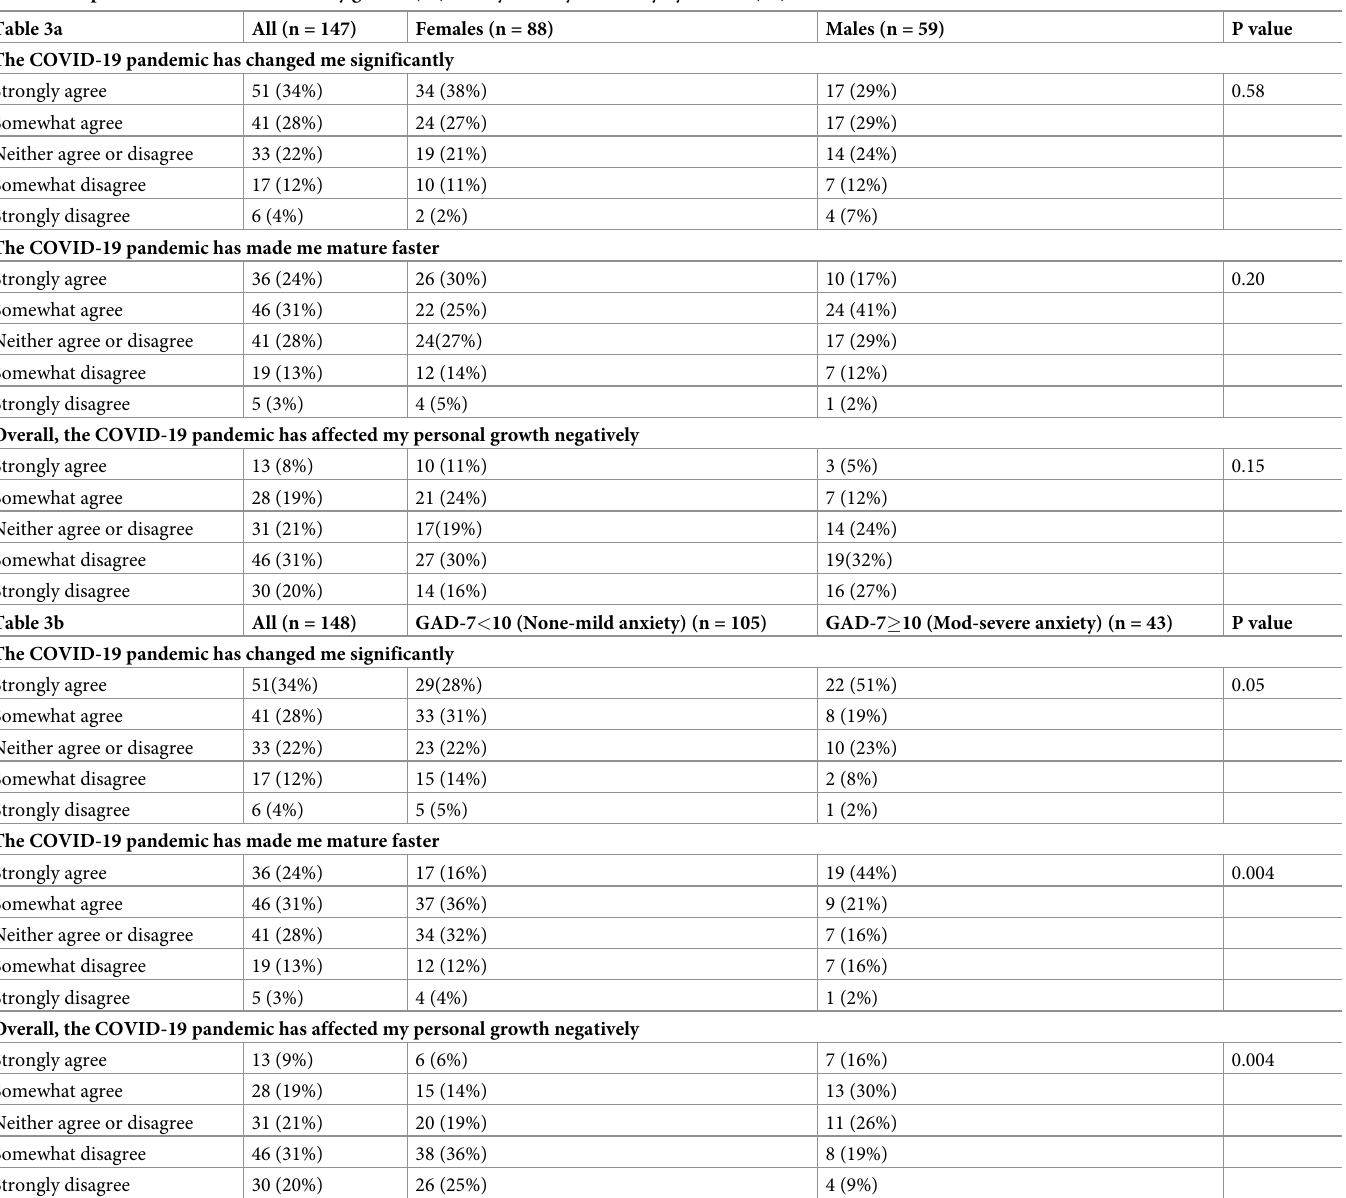
Table 3. Impact of COVID-19 stratified by gender (3a) and by severity of anxiety by GAD-7 (3b). Table 3a